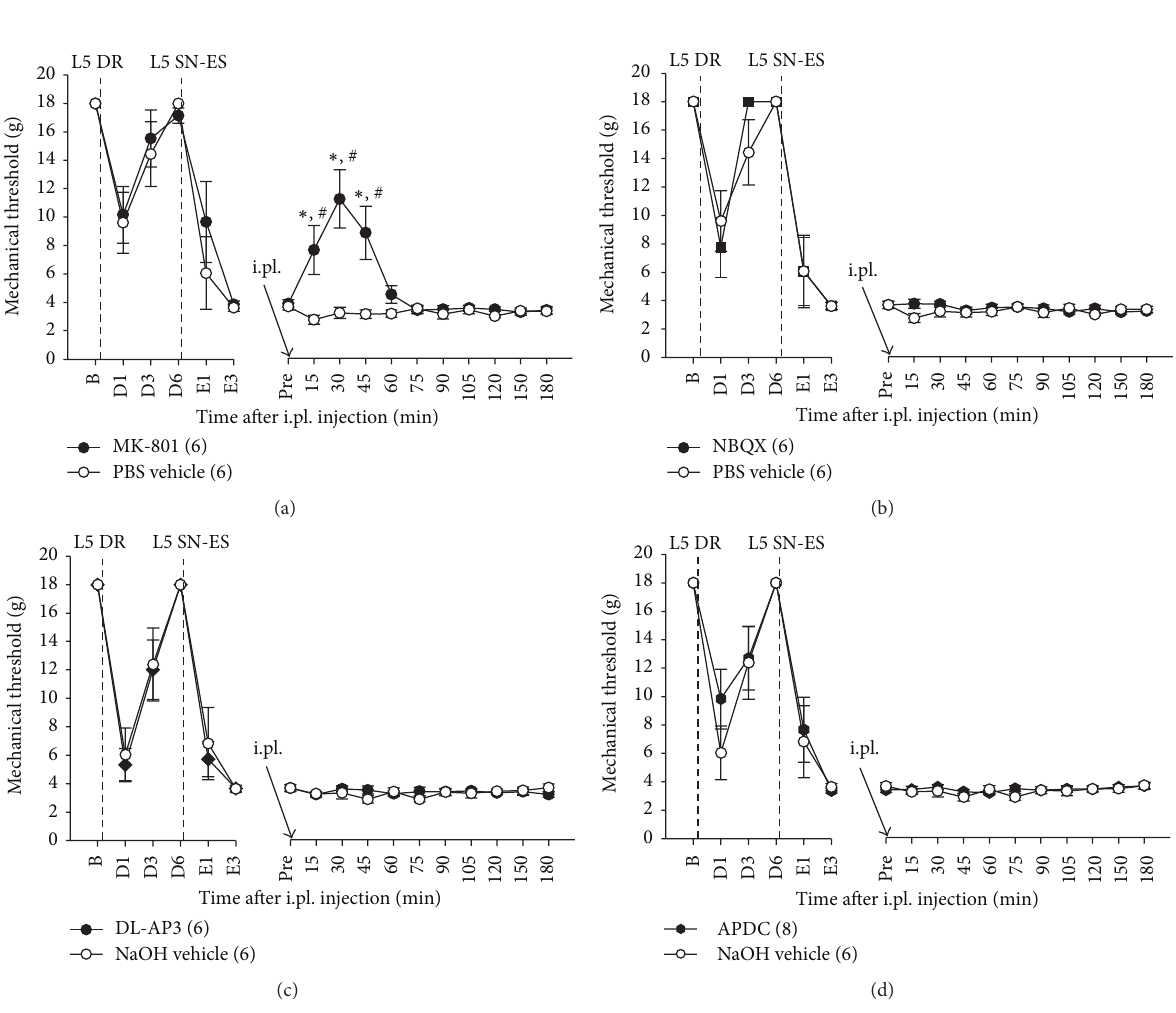
Figure 4: Effects of MK-801, NBQX, DL-AP3, or APDC posttreatment in the periphery on ES-induced PWT reduction. (a) In rats with L5 DR, an i.pl. injection of MK-801 (20nM) administered 3 days after the ES of L5 SN (L5 SN-ES) into the midpoint of the L4 plantar dermatome resulted in a significant increase in ES-induced decreased PWTs at 15, 30, and 45 min after treatment compared with vehicle-treated controls. (b–d) No differences in ES-induced decreased PWTs were observed between animals treated with NBQX (100nM), DL-AP3 (70nM), or APDC (20 nM) and vehicle-treated controls. The abbreviations B, D, E, and Pre denote the baseline before DR, postoperative days after DR, postoperative days after ES, and baseline prior to i.pl. injection, respectively. The values in parentheses indicate the number of animals used. The error bars represent the SEM. ∗ 𝑃 < 0.05 versus vehicle group. # 𝑃 < 0.05 versus